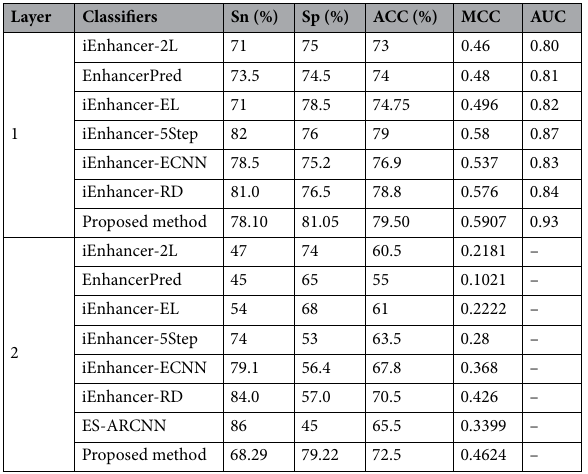
Table 6. Independent tests based comparison of state-of-the-art methods with the proposed method.